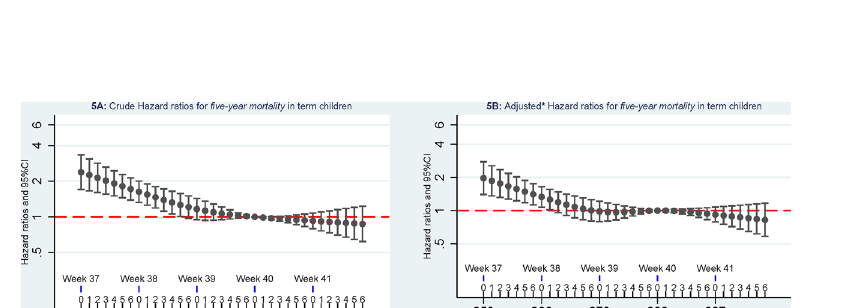
Fig 4. Hazard ratios for infant mortality. Model 1: the results were adjusted for caesarean section (yes or no), maternal age ( < 25, 25 – 30, 30 – 35, > = 35), parity (1, 2, and 3), and birth year (1997 – 1999, 2000 – 2002, 2003 – 2005, and 2006 – 2008). Model 2, the results were additionally adjusted for maternal education (low, middle, and high) and maternal cohabitant status during birth (yes, no). Restricted analyses: the analyses were restricted to pregnancies without registered morbidity within one year before delivery or within 30 days after delivery using the same adjustments in Model 2.